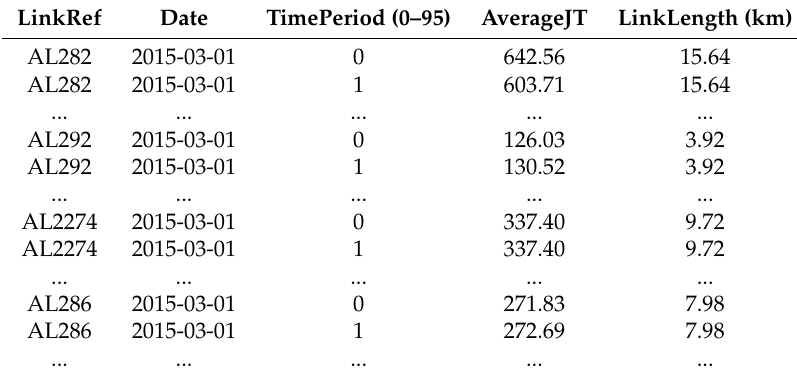
Table 2. Description of the dataset provided by Highways